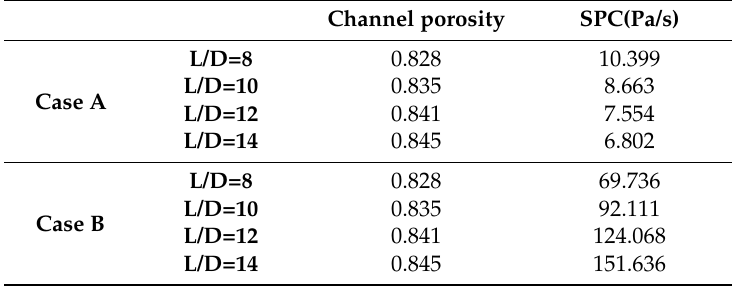
Figure 8. Comparison with the friction factor result of Haaksman et al. [9] as a function of Reynolds number. Table 2. Interpolated value from fixed superficial velocity at Reynolds number